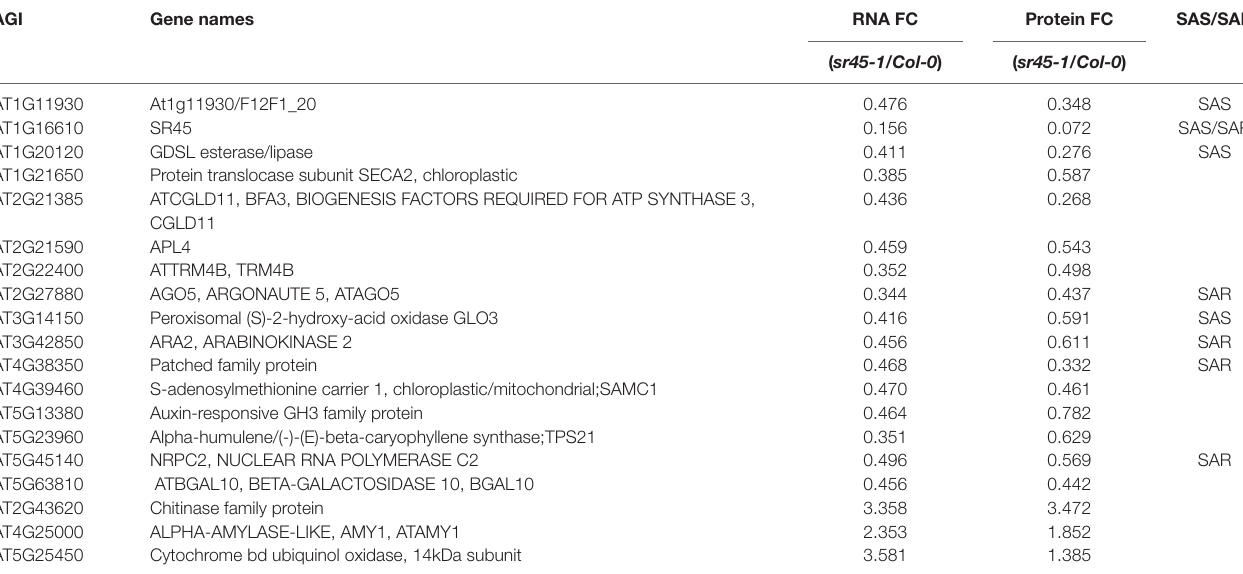
TABLE 1 | A summary of genes that are differentially expressed in an SR45-dependent manner at both RNA and protein levels. Their identity as either SAS or SAR genes is also listed below. AGI Gene names RNA FC Protein FC